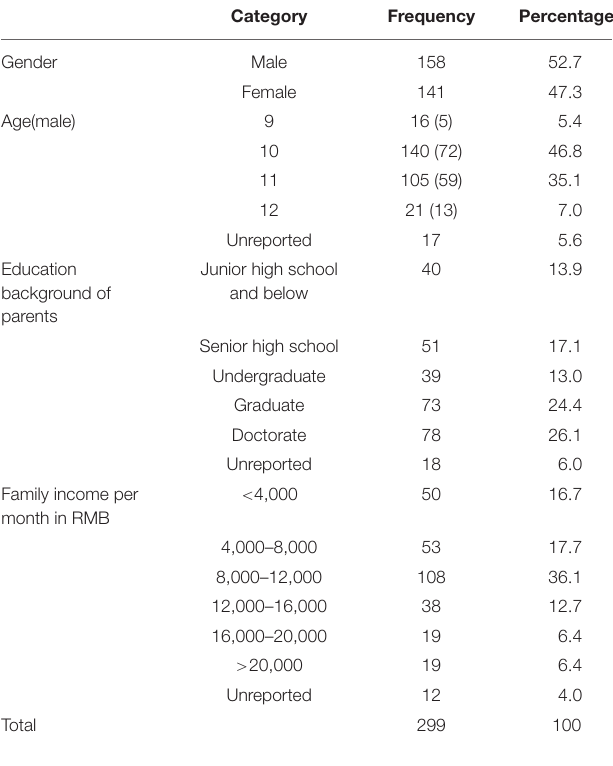
TABLE 1 | Sample demographics